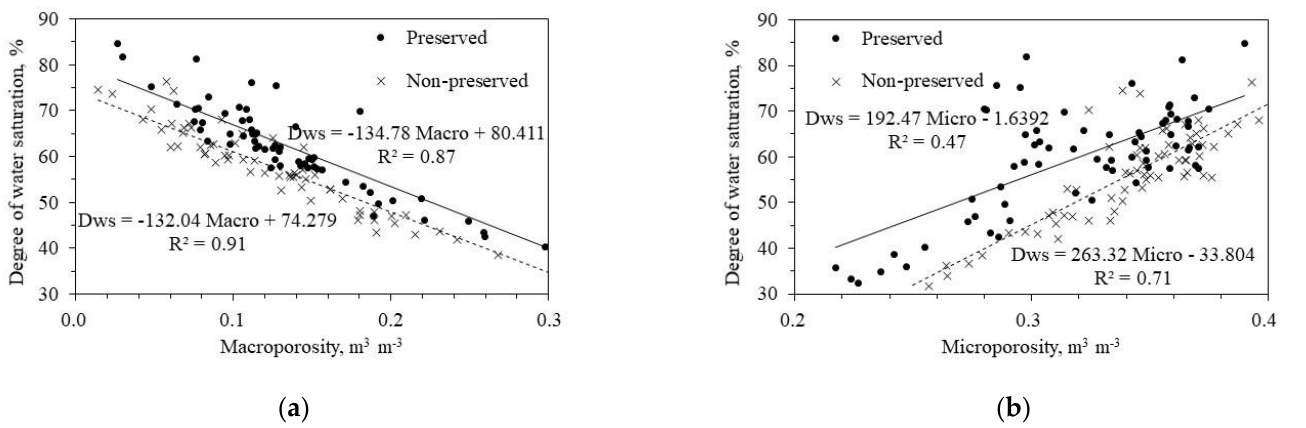
Figure 8. Regression between physical properties for soil with preserved and non-preserved structure. Macro = macroporosity; Micro = microporosity; Dws = degree of water saturation.